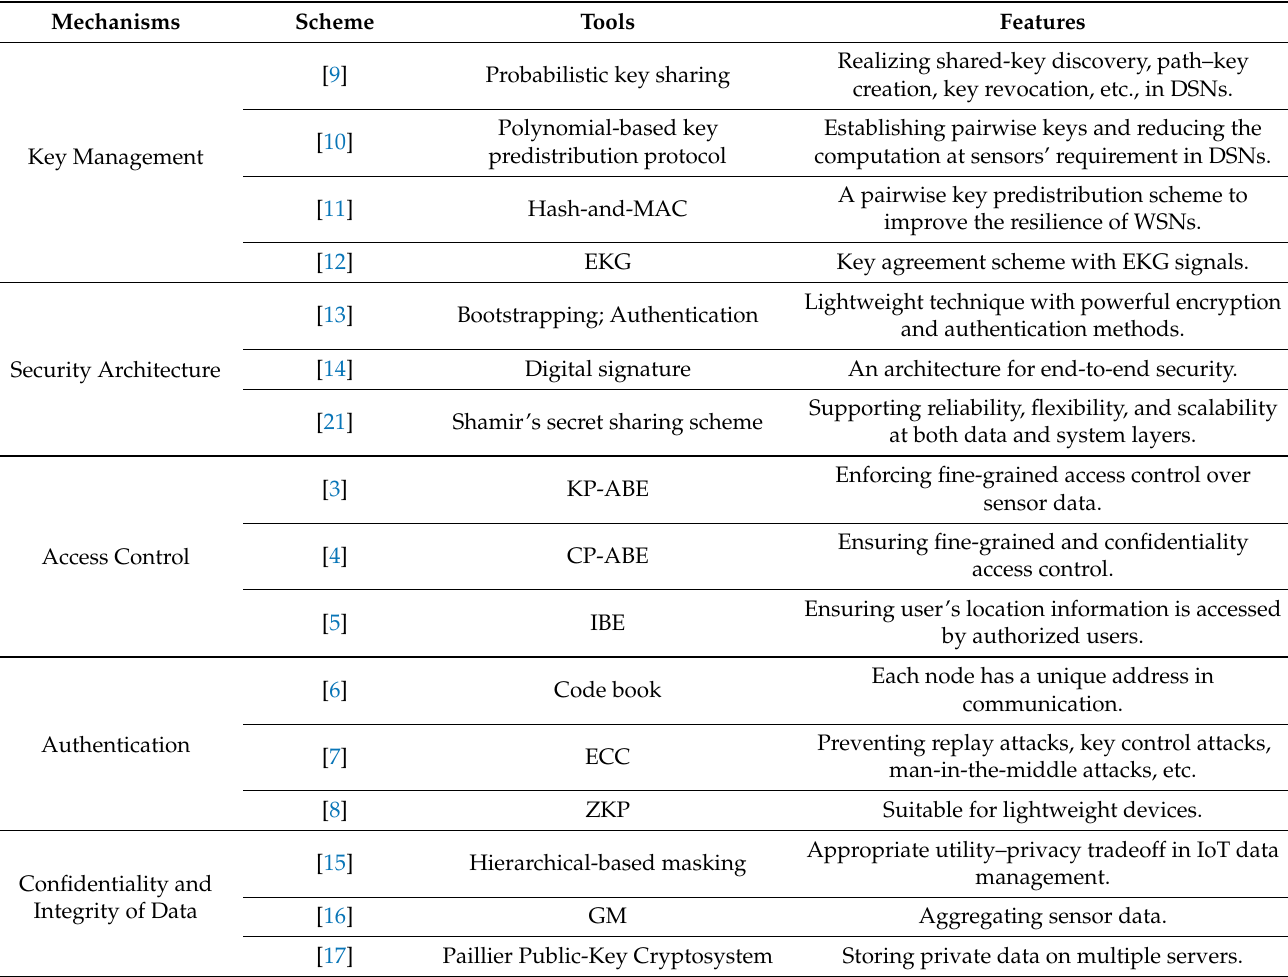
Table 2. Solutions to privacy-persevering